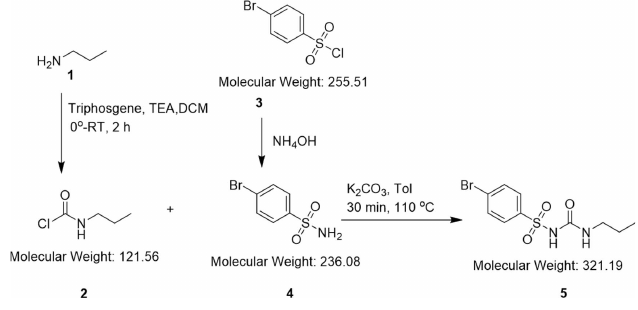
Figure 6 Reaction scheme for the synthesis of 4-bromo- N -(propylcarbamoyl)-